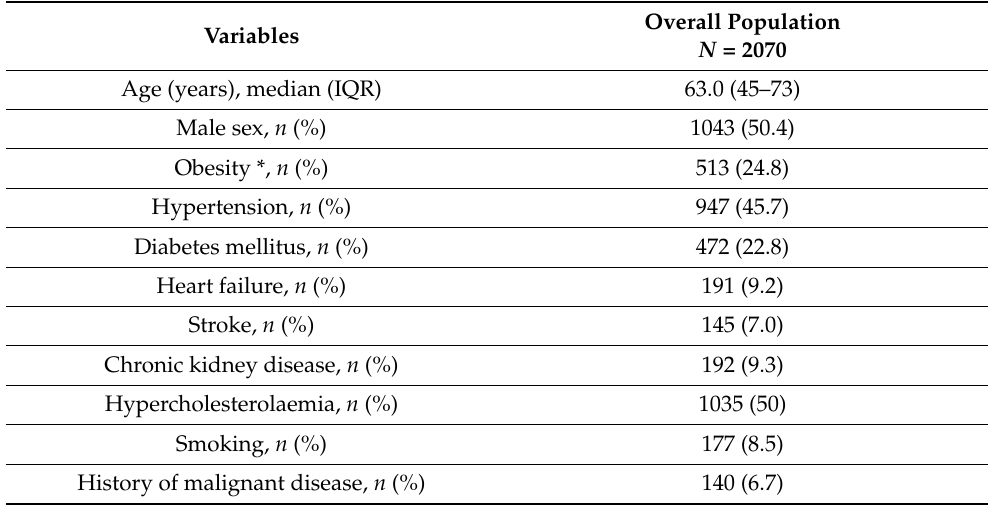
Table 1. Baseline characteristics in total